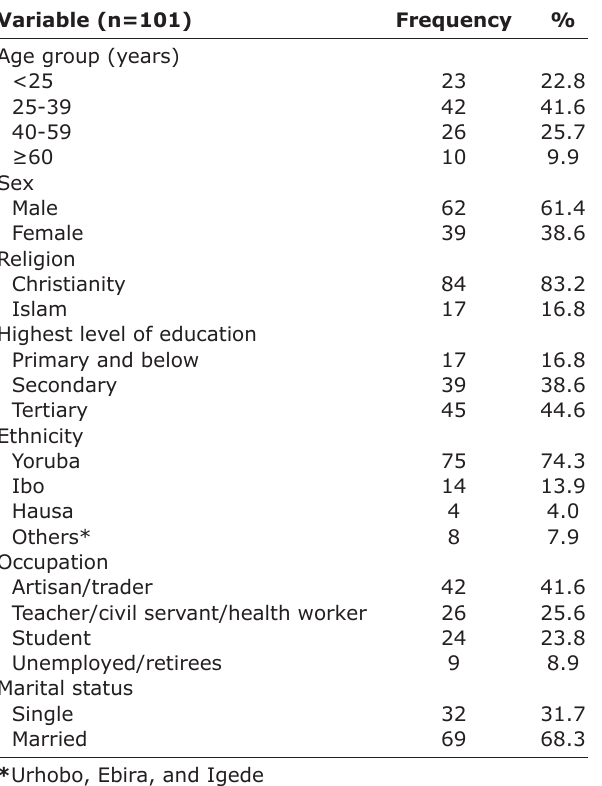
Table-1: Sociodemographic characteristics of Lassa fever confirmed persons, Federal Medical Centre, Owo.